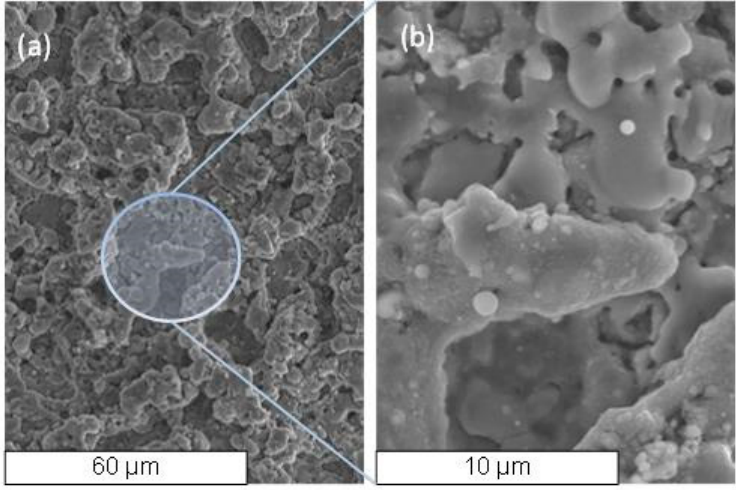
Figure 12. SEM micrograph of the EDM surface ( a ) and magnified ( b ).